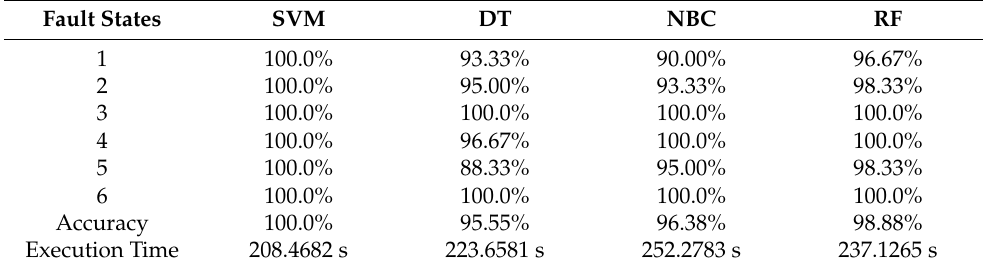
Table 9. The comparative analysis of the diagnostic accuracy of different classification